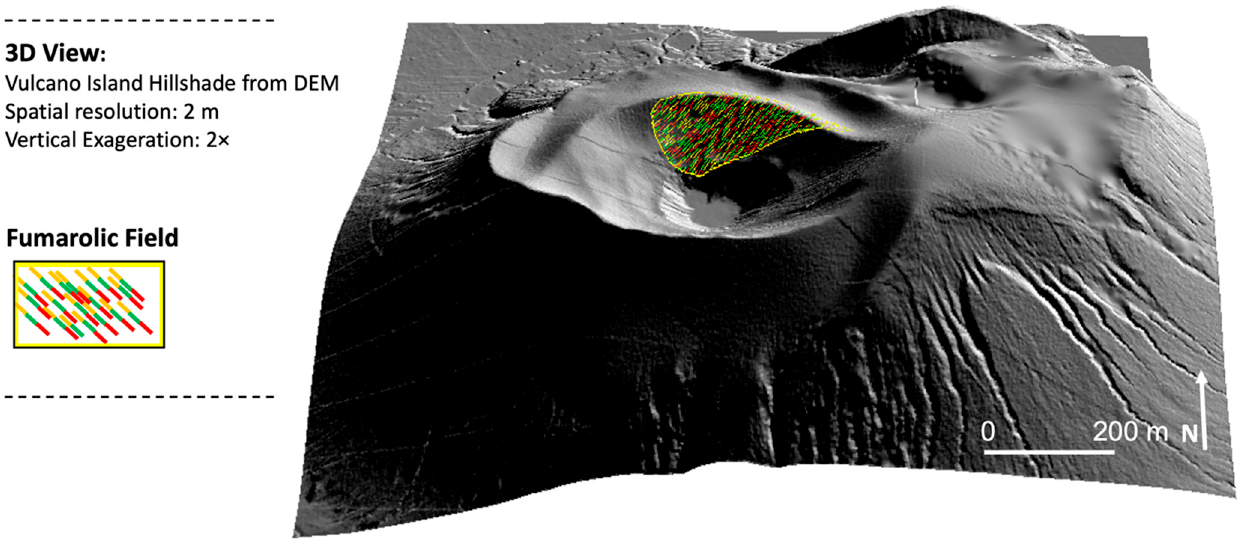
Figure 2. Zoomed 3D view of La Fossa cone. The main fumarolic field on the northern rim is highlighted.